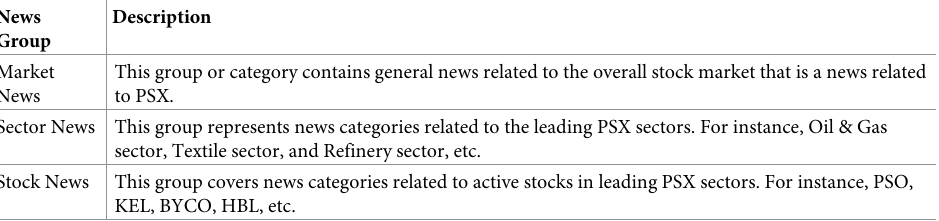
Table 1. News groups in the stock